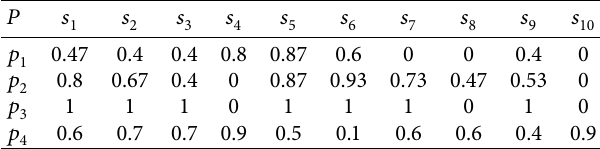
Table 14: Tabular representation of ( F, S ) part 2.